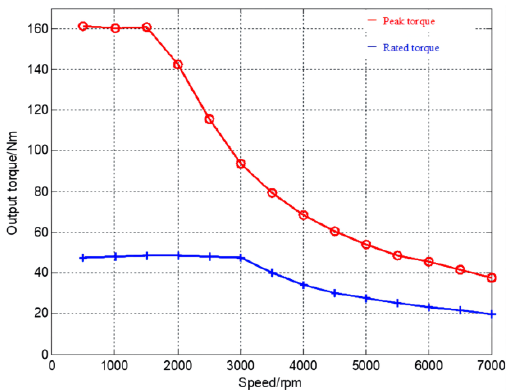
Figure 1. Motor efficiency.